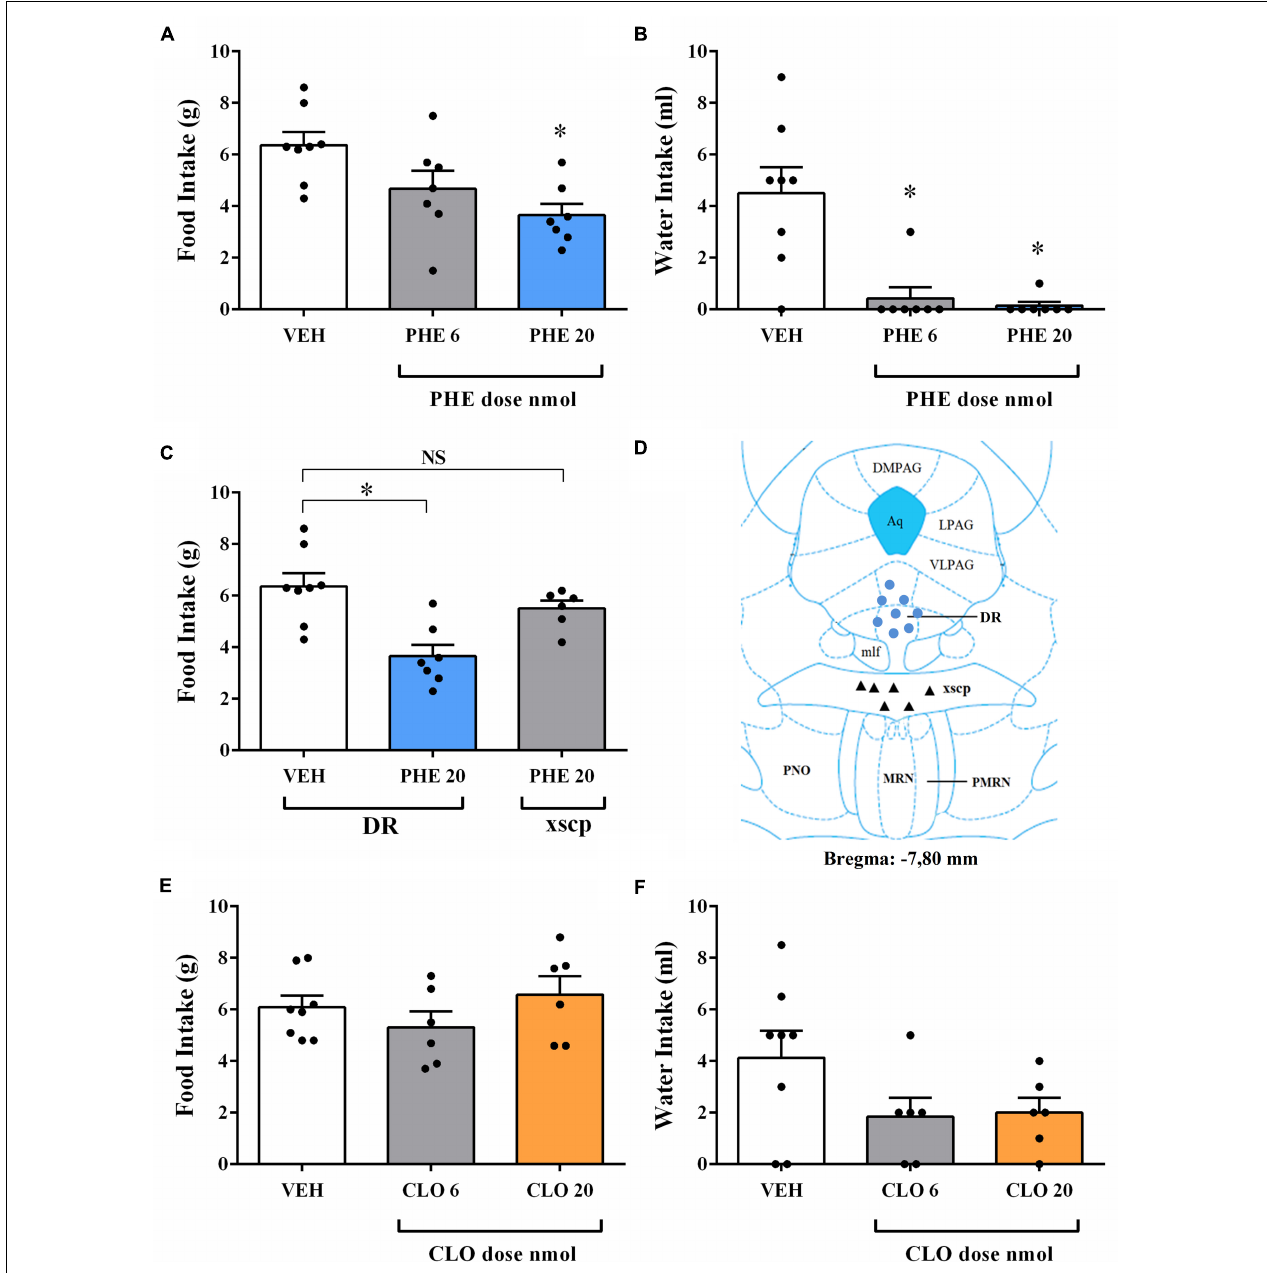
FIGURE 3 | Food and water intake after injection of the α -1 adrenoceptor agonist phenylephrine (PHE) or the α -2 adrenoceptor agonist clonidine (CLO) into DR of fasted rats. (A) Changes in the amount of food intake after injection with vehicle (VEH) or PHE at 6 and 20 nmol doses into DR of fasted rats. (B) Changes in the amount of water intake after treatment with VEH or PHE at 6 and 20 nmol doses into DR of fasted rats. (C,D) Effect of the PHE 20 nmol injection into the decussation of the superior cerebellar peduncle (xscp) on food intake in fasted rats. MR = median raphe nucleus; Aq = cerebral aqueduct; DR = dorsal raphe nucleus; NS = non-significant. (E) Changes in the amount of food intake after injection with VEH or CLO at 6 and 20 nmol doses into DR of fasted rats. (F) Changes in the amount of water intake after injection with VEH or CLO at 6 and 20 nmol doses into DR of fasted rats. In all experiments, separate rats were used for each dose; each rat received only a single injection of drug or vehicle. Data represent the mean ± SEM * p < 0.05 vs. vehicle group. One-way ANOVA followed by Tukey’s post hoc test ( n = 6–8 per